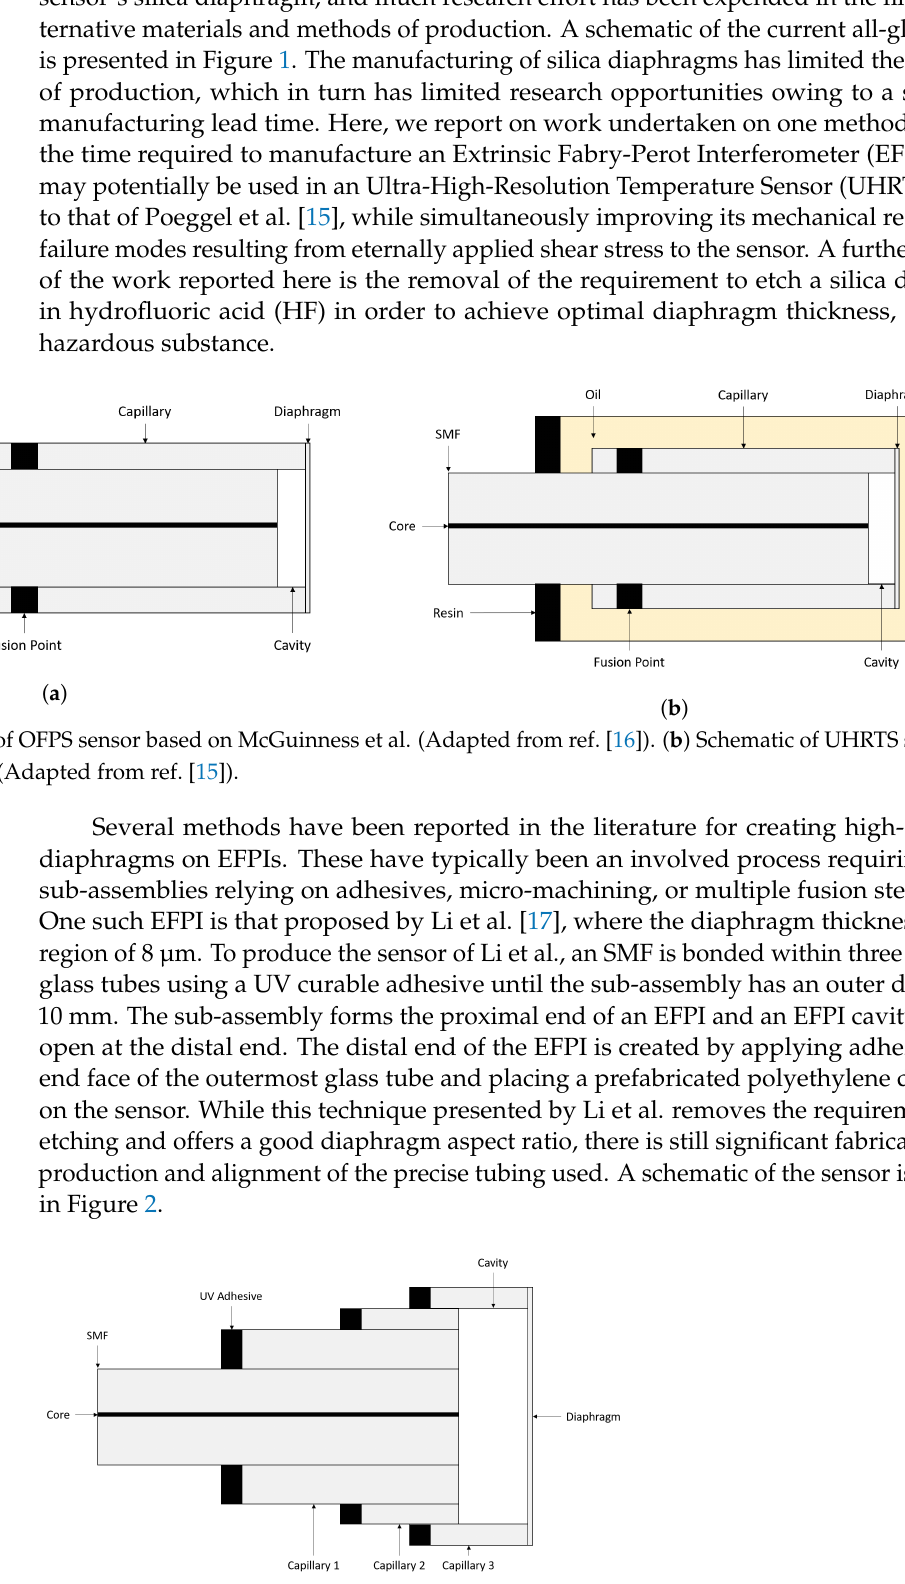
Figure 2. Schematic of an EFPI sensor based on Li et al. (Adapted from ref.